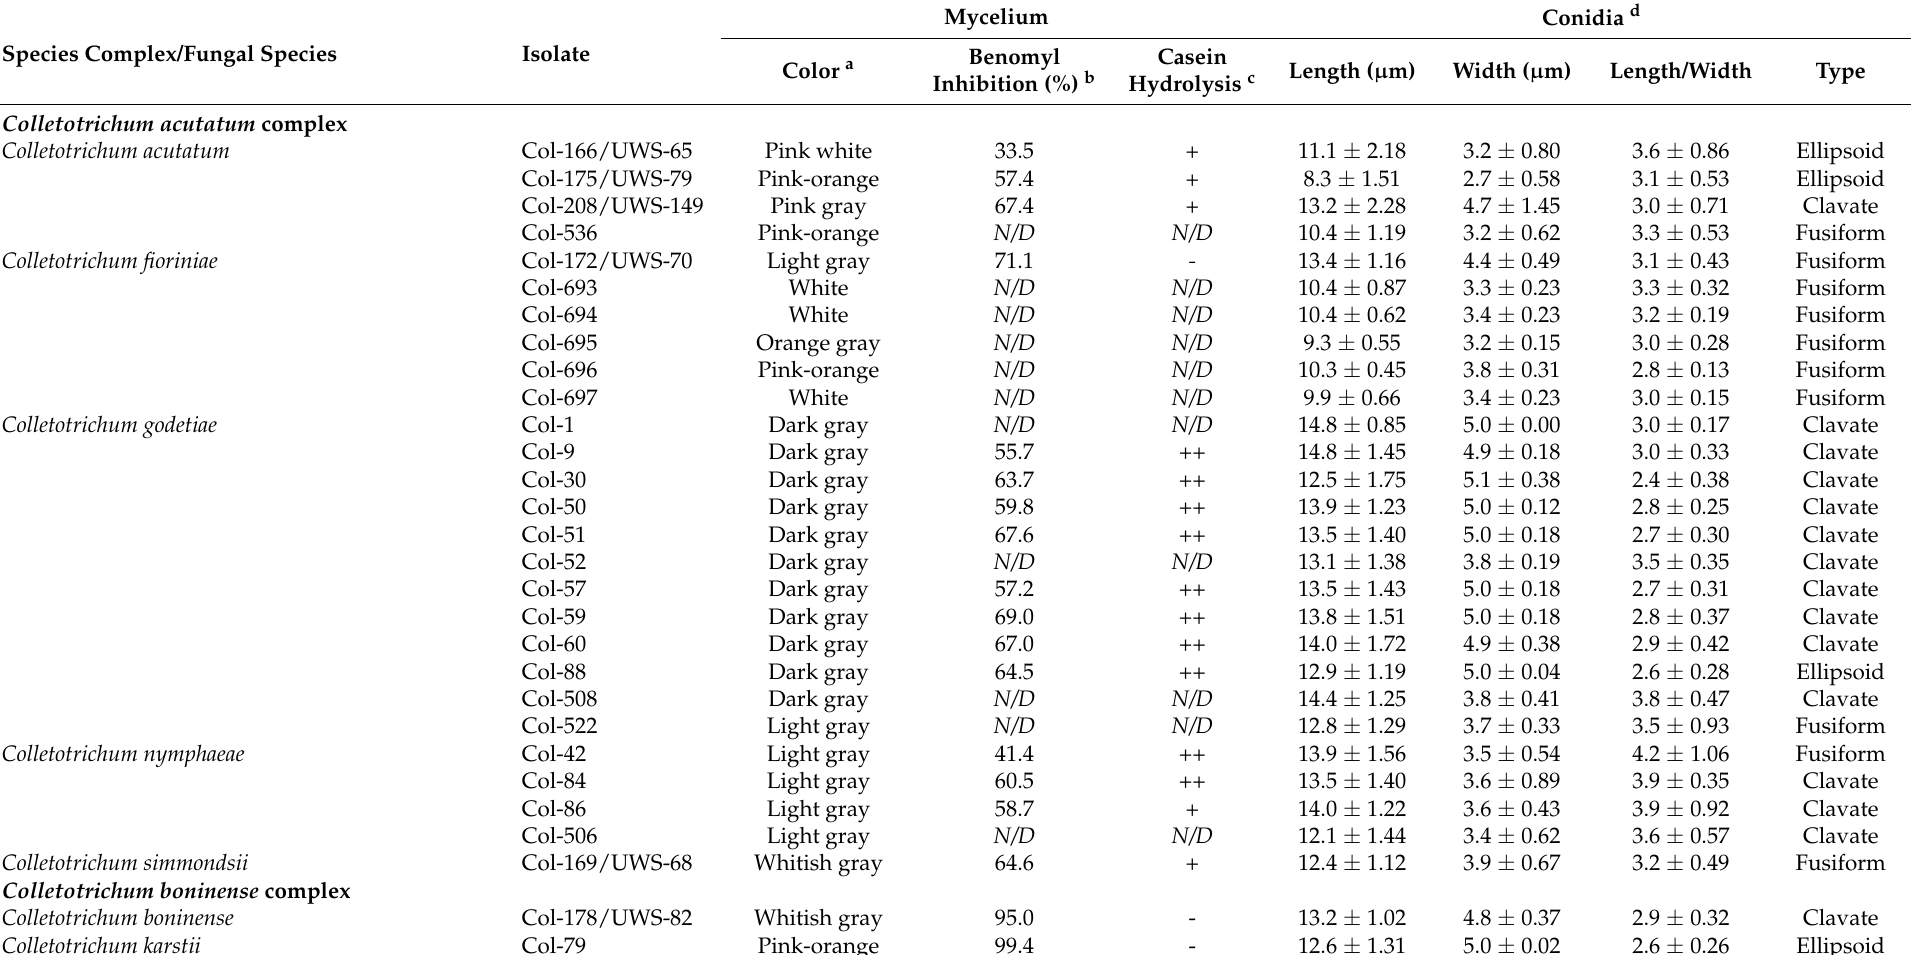
Table 2. Phenotypical characters of mycelia and conidia of representative Colletotrichum spp. isolates belonging to C. acutatum , C. boninense , and C. gloeosporioides species complexes collected from olive trees and other hosts showing anthracnose symptoms from different geographic